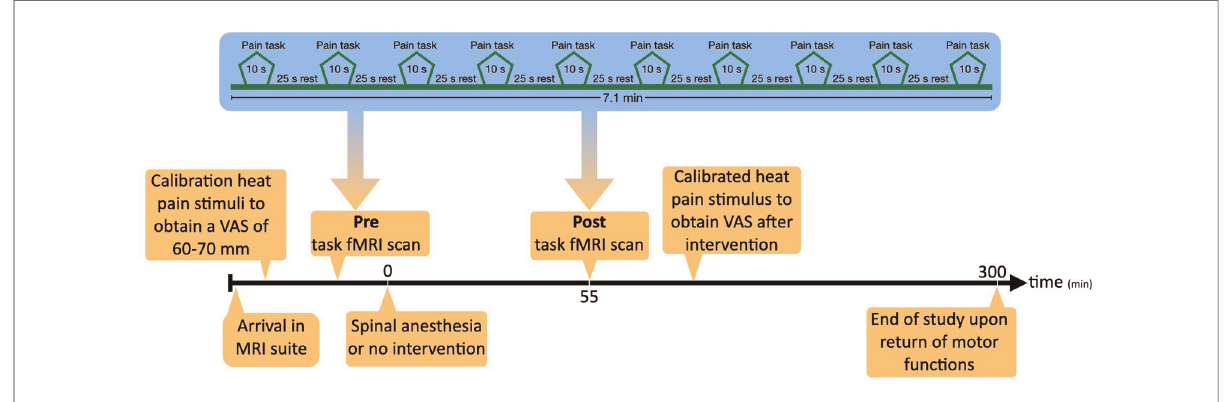
FIGURE 1 The timeline of the